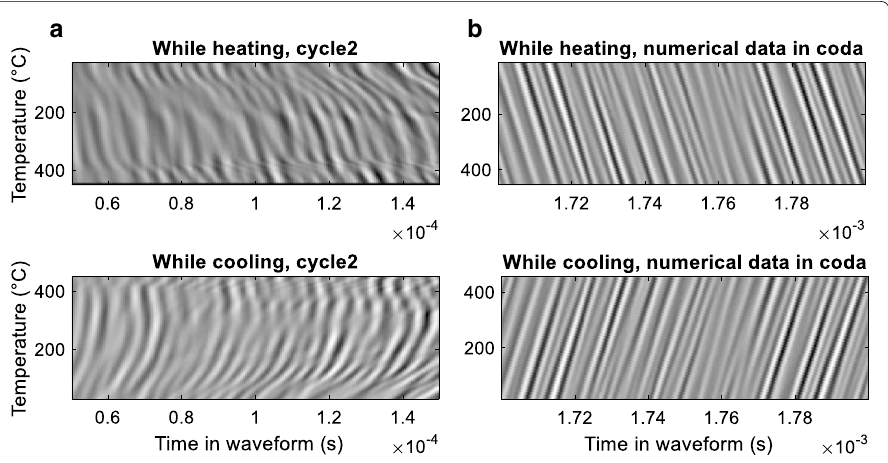
Fig. 9 a Zoom in a 100 µs long window (from 50 to 150 µs, after first arrivals) of the waveforms recorded in the laboratory during second heating and cooling cycles. b Zoom in the last 100 µs of the waveforms recorded in the simulation. Grayscale indicates the normalized amplitude of the particle